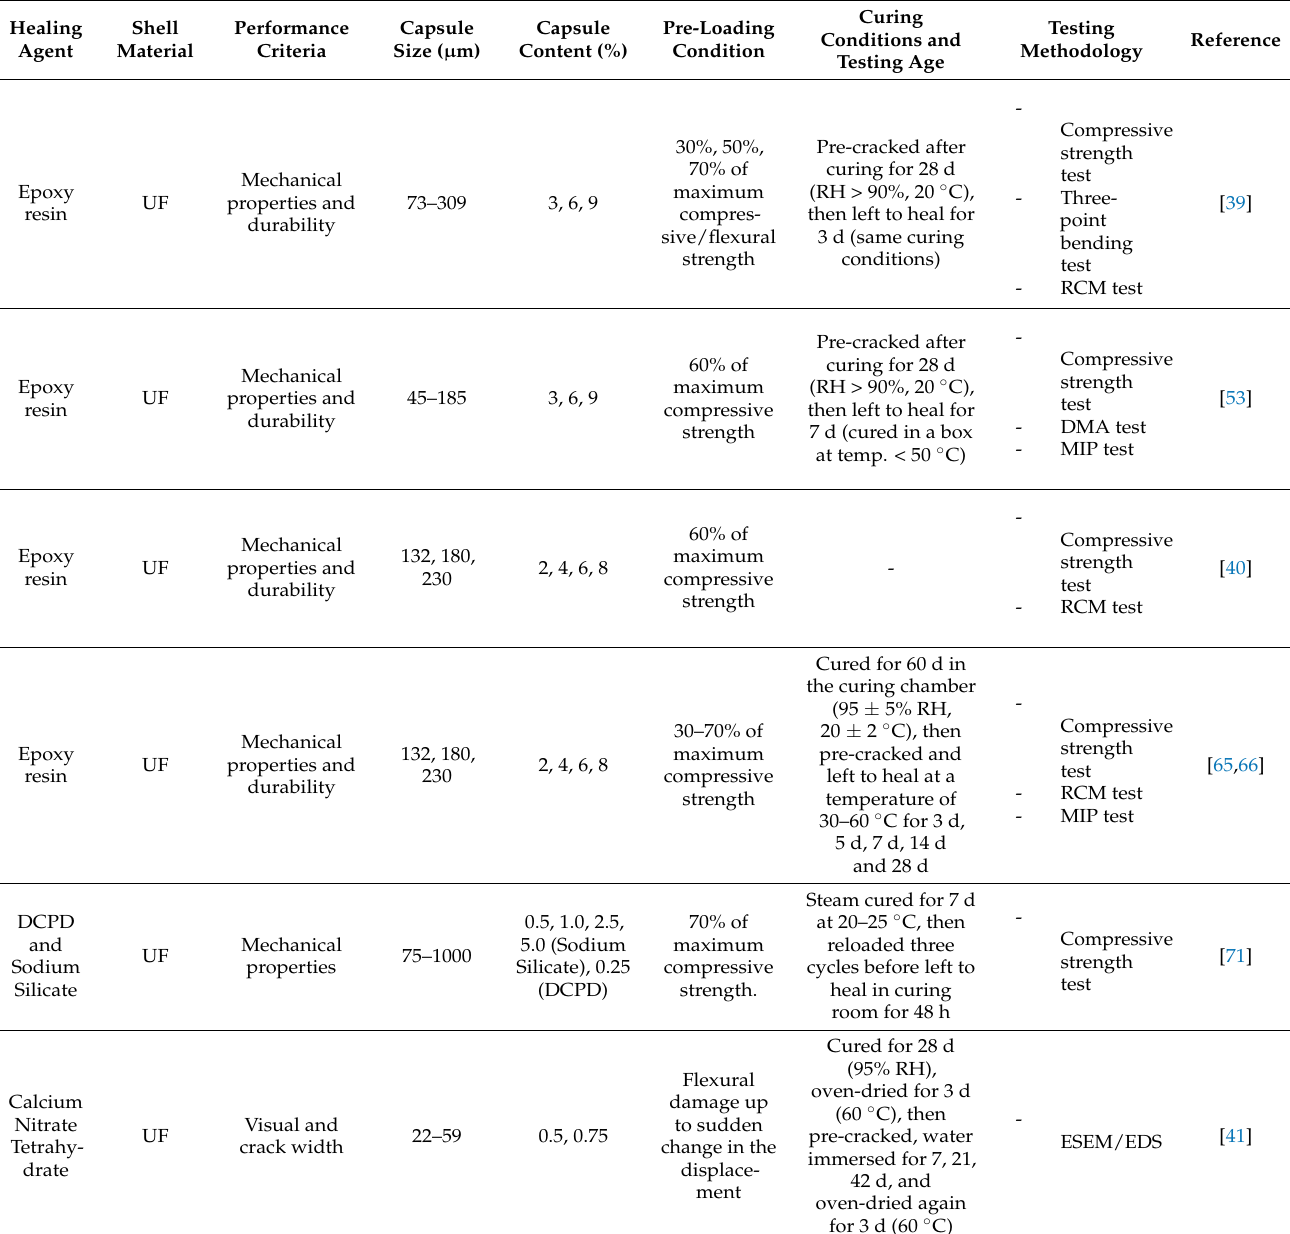
Table 3. Performance of self-healing system in concrete